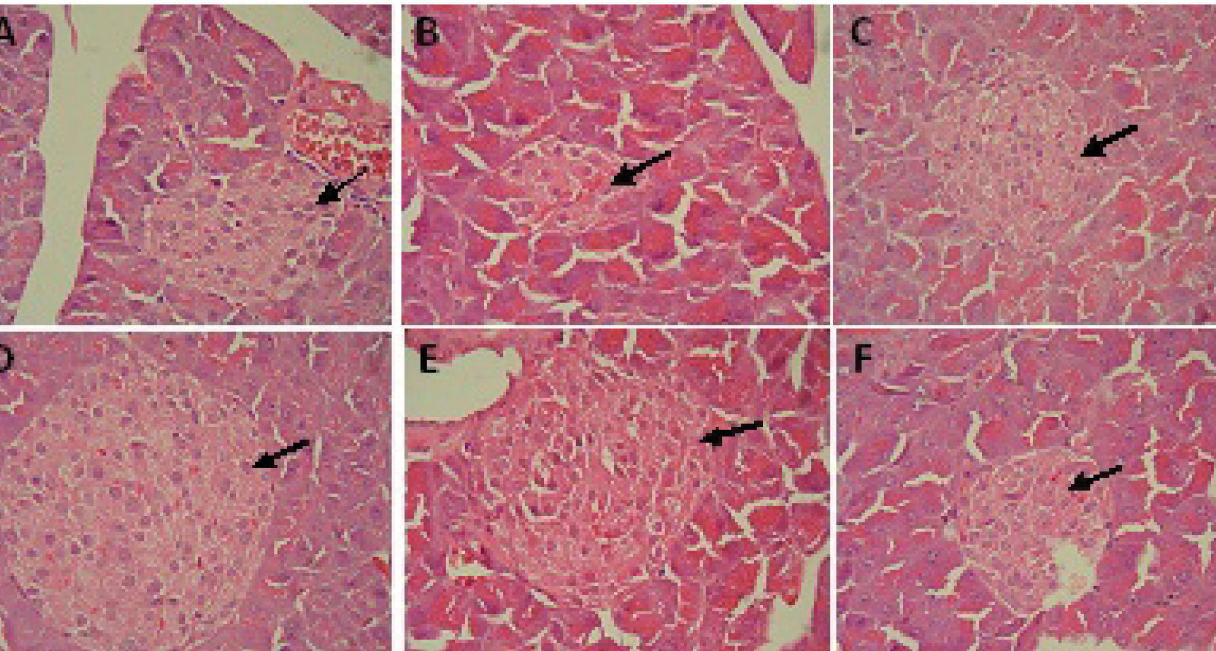
FIGURE 2 - Effect of different doses of betulinic acid on islets and pancreas histological analysis in STZ-NA diabetic mice. A: Control, B: Diabetic, C: Diabetic+BA10mg, D: Diabetic+BA20mg, E: Diabetic+BA40mg, F: Metformin. (H&E stain × 400). Arrow: Islets of Langerhans.